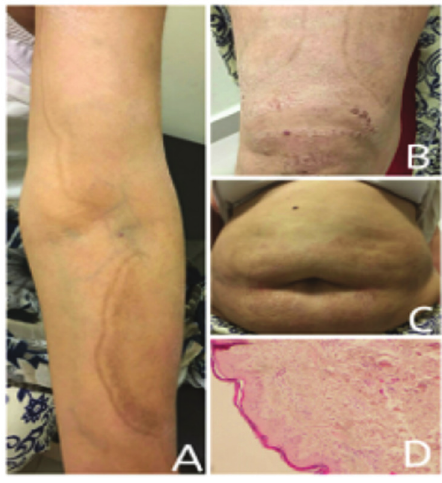
Figure 1 - Specific characteristics of Case 1 Figure 2 - Specific characteristics of Case